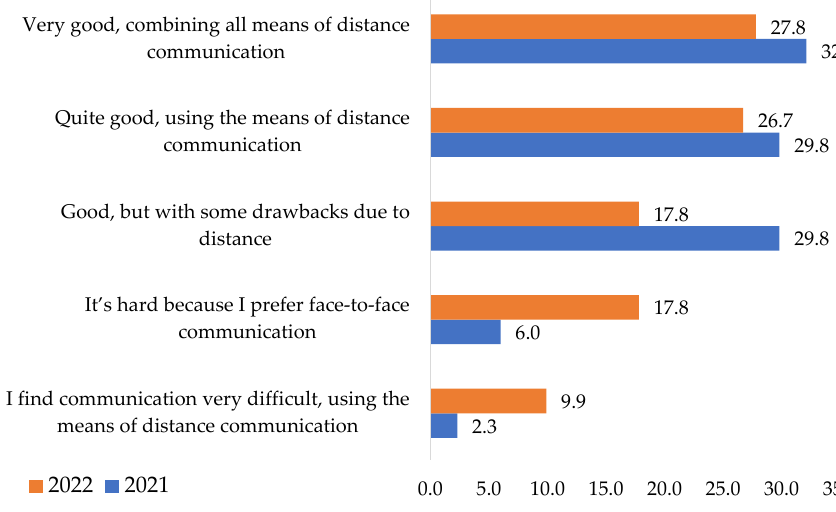
Figure 7. E-mail conversation with co-workers. Source: Data from field quizzes, 2021, 2022. The chi-square test shows that the variables are not associated. Moreover, this part of the H3 hypothesis is rejected. Opinions on e-mail communication remained unchanged during the two years. During the study period, 32.1% of respondents for 2021 and 27.8% for 2022 consid- ered direct communication with colleagues very good, combining all means of distance communication. A proportion of 29.8% in 2021 and 26.7% in 2022 regarded it as quite good, using the distance instruments of communication. Only 6% in 2021 and 17.8% in 2022 said it was difficult, preferring face-to-face communication, as shown in Figure 8.